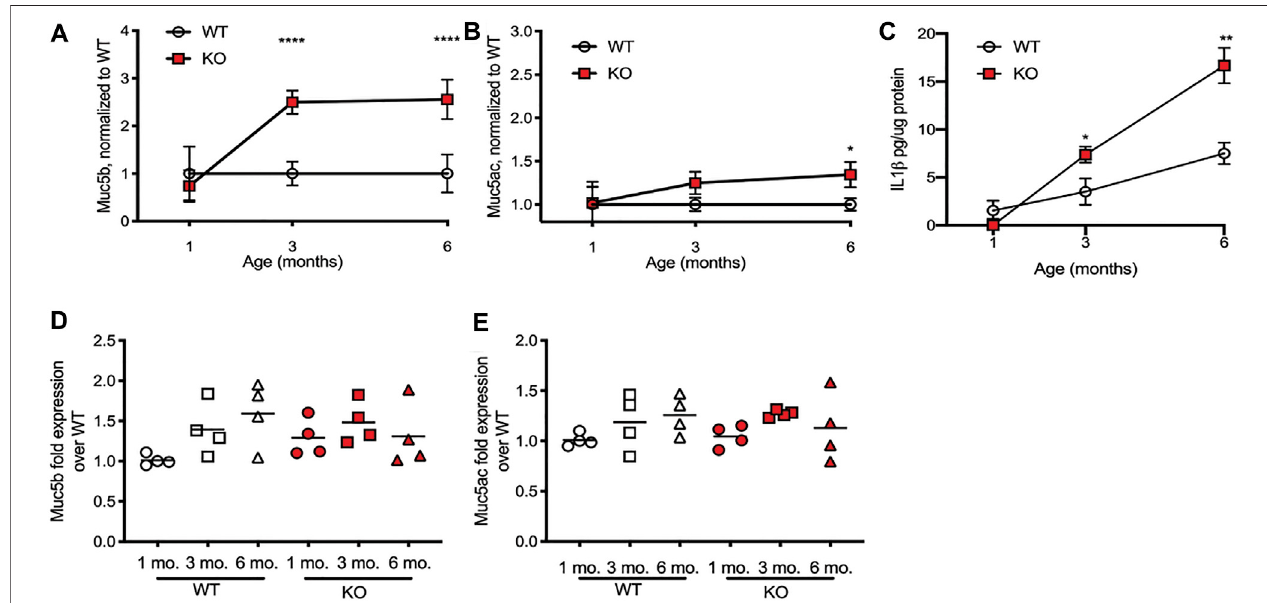
FIGURE1| MucinincreasesinBALFintheCFTR-KOratoverage.Wild-type(WT)andCFTR-KO(KO)ratsat1,3,and6 monthsofageunderwentbronchoalveolar lavage to detect mucins in the resultant fl uid (BALF). (A) Muc5b and (B) Muc5ac protein detection on dot blot was normalized to the WT at each age. (C) IL-1 β concentrations in the BALF were detected via ELISA. Data are represented as mean ± SD and analyzed via a two-way ANOVA with Sidak ’ s post-test. n = 6/group. * p < 0.05, ** p < 0.01, **** p < 0.0001. mRNA quanti fi cation from lung tissue of the same rats was conducted on (D) Muc5b and (E) Muc5ac expression, and were compared to the housekeeping gene Gapdh and then normalized to the 1 month old WT to present ΔΔ Ct. The line represents the mean. Data were analyzed with one- way ANOVA using Dunnett ’ s post-test.